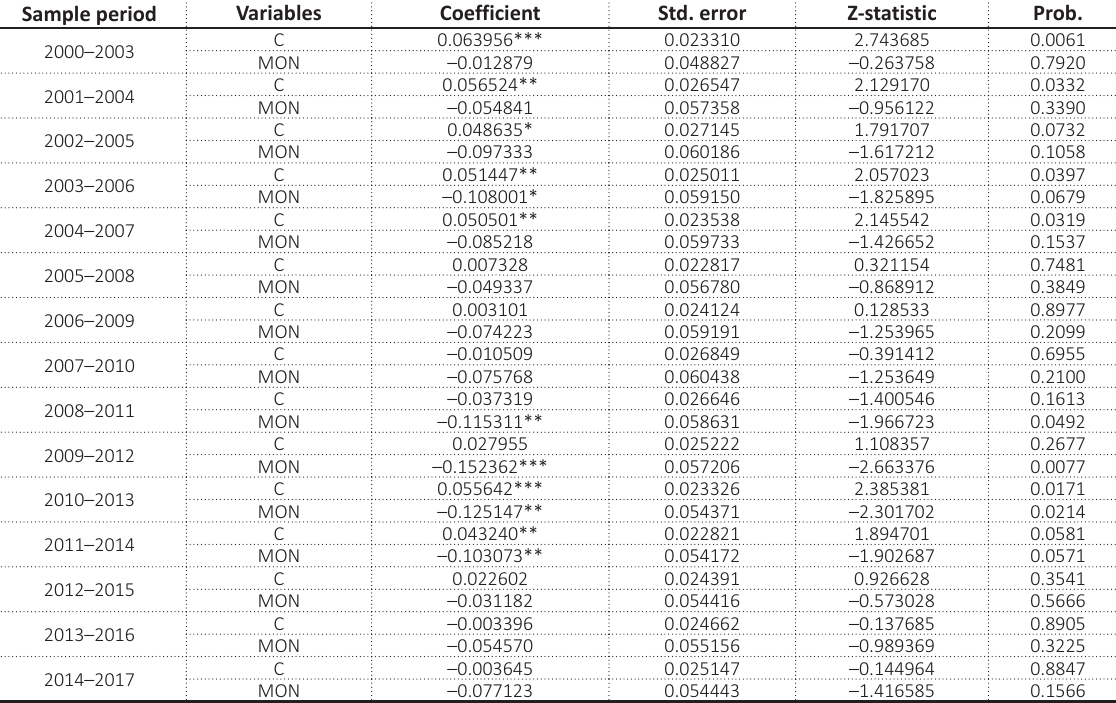
Table 2. Results of time-varying day-of-the-week effect Sample period Variables Coefficient Std. error Z-statistic